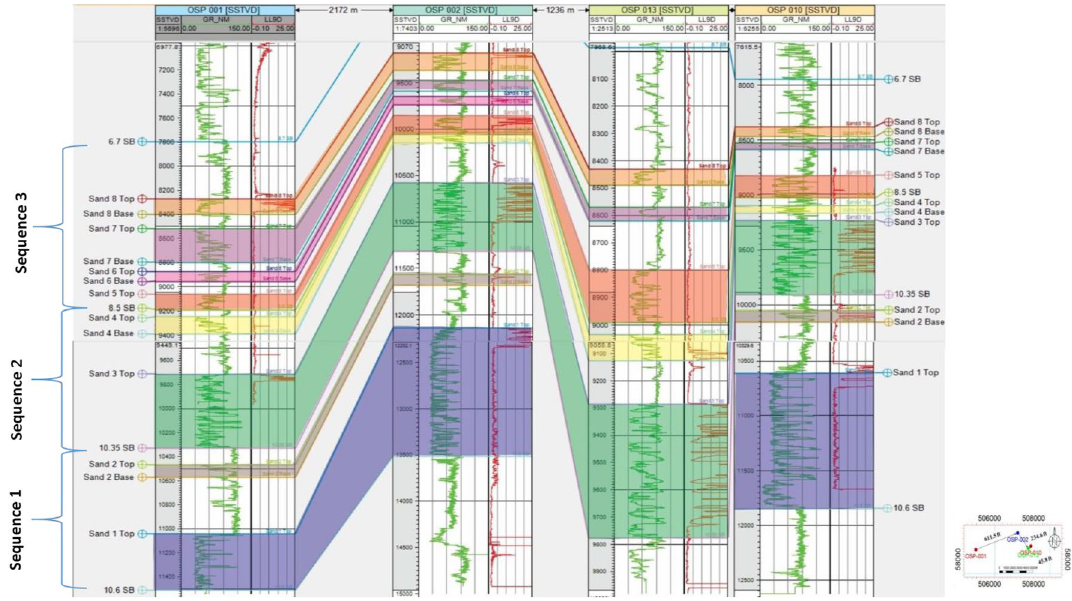
Fig. 11 Cross section of the studied well showing identified hydrocarbon bearing reservoirs using the sequence stratigraphic